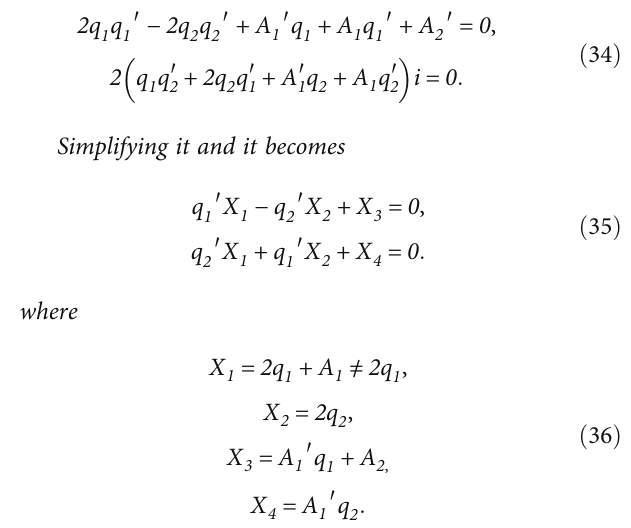
Figure 5: (a) Time series solution of system (4) approaches asymptotically to the equilibrium point E except c 2 = 0 : 2 ; ; α = 0 : 25, and β = 0 : 2 .